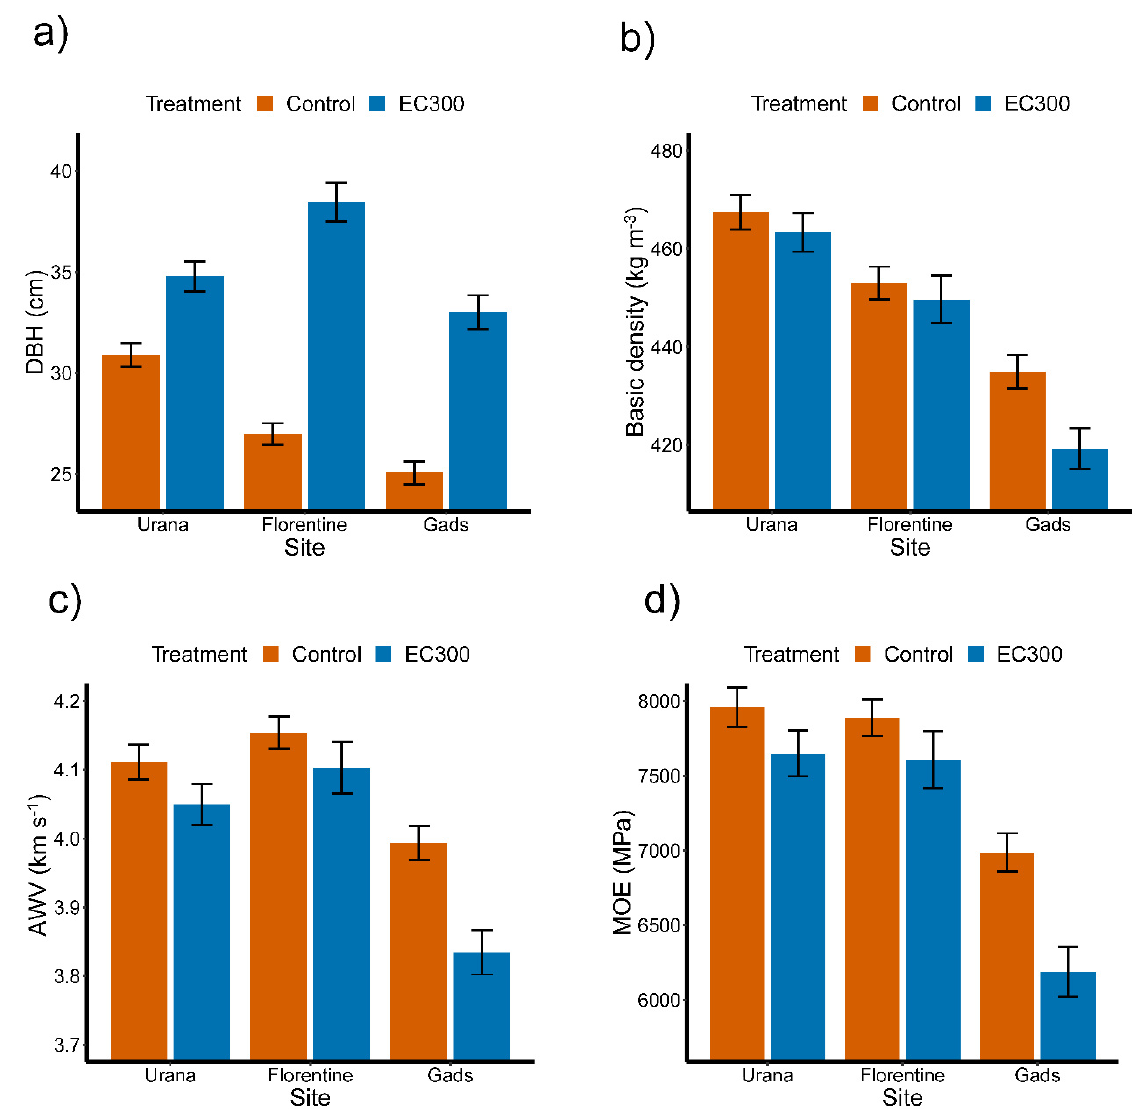
Figure 2. Least-square means and their standard errors estimated from the fitted first model showing the effect of commercial thinning (EC300; blue bars) relative to the unthinned control (orange bars) on tree size (( a )—DBH) and wood properties (( b )—Basic density; ( c )—Acoustic Wave Velocity; ( d )—Modulus of Elasticity) at Urana, Florentine and Gads. Table 3. Statistics for commercial thinning (EC300) vs. control treatment across three sites of the Eucalyptus nitens thinning trials. Results are F-tests for fixed effects and variance with standard deviation in parentheses for the random effects. Random effects are denoted in italics. Pruning was considered as a co-variate and was not included in the interaction term.